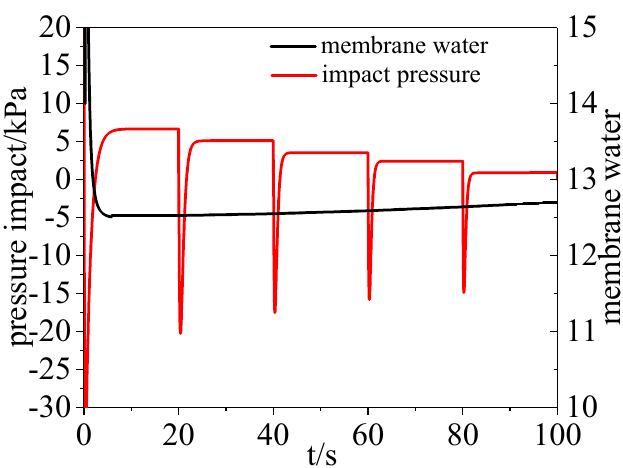
Figure 9. Water content in the membrane and pressure impact on membrane electrode assembly (MEA), from simulation results.